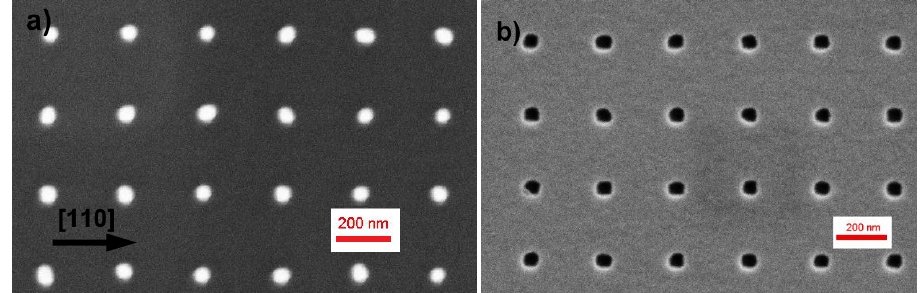
Figure 1. SEM images of ( a ) the silicon mold used for NIL patterning of GaAs; ( b ) a patterned GaAs (001) surface.